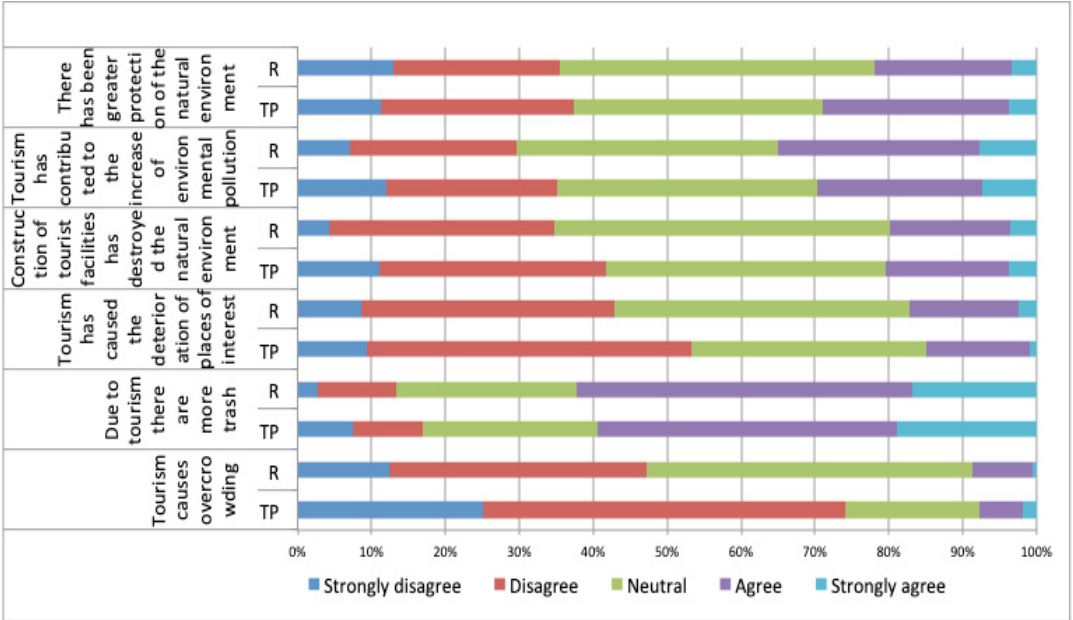
Figure 2. Ratings of stakeholders’ perception of tourism impacts. Note: R = Residents, TP = Tourism Practitioners.